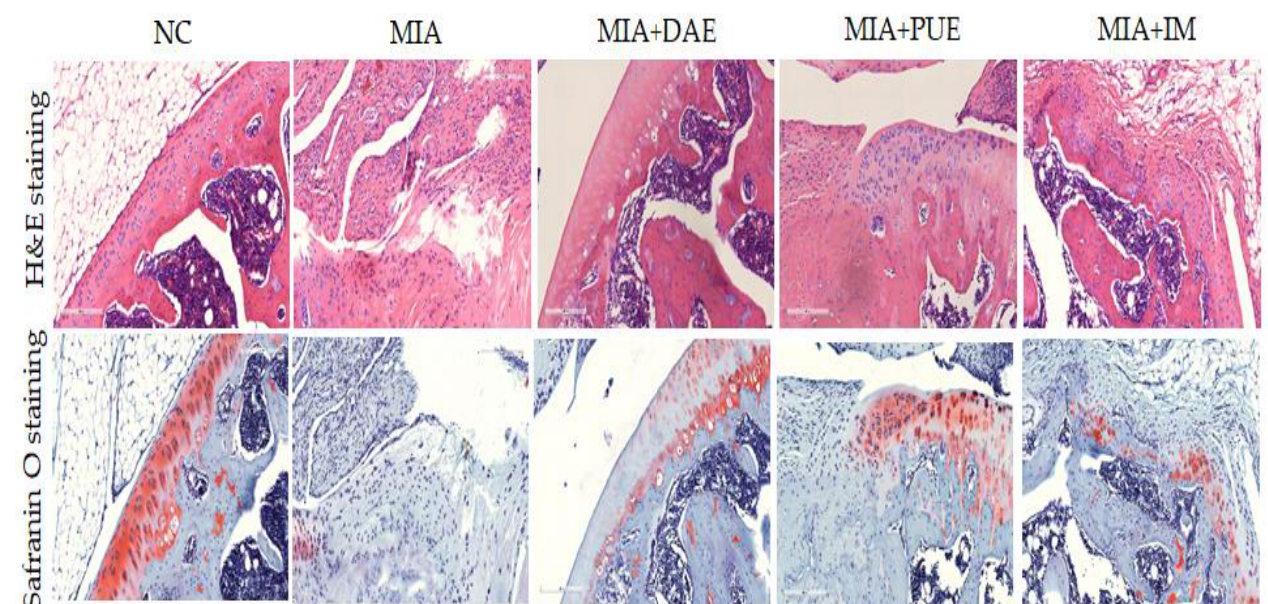
Figure 4. Effects of DAE and PUE on histopathological features of knee joint tissue in MIA-induced OA rats. Representative photographs of knee joint sections stained with H&E and Safranin O ( × 100 magnification). NC, untreated; MIA, only MIA-induced; MIA + DAE, MIA-induced and DAE-treated; MIA + PUE, MIA-induced and PUE-treated; MIA + IM, MIA-induced and IM-treated rats.